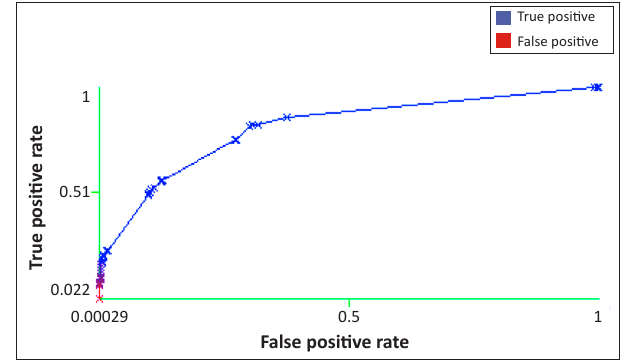
FIGURE 2: Overbooked flights data fields